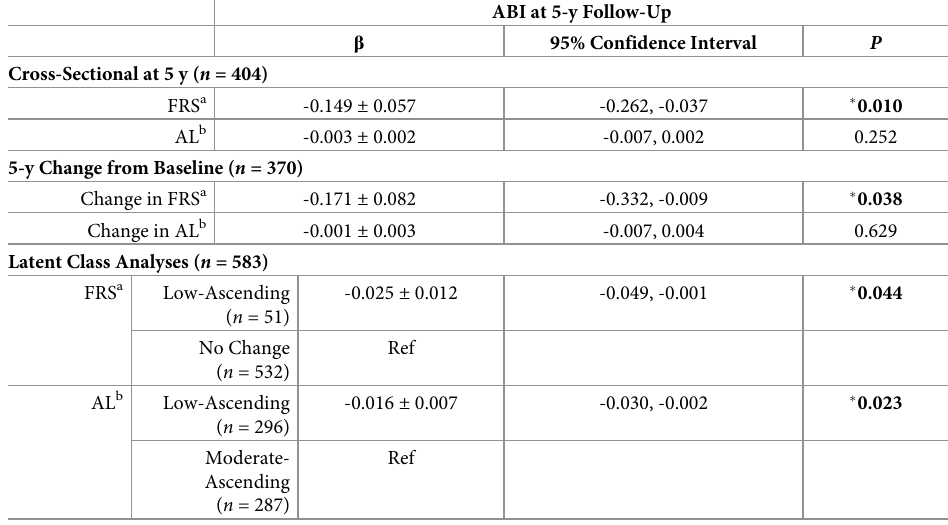
Note: Boldface indicates statistical significance ( � P < 0.05). a Models with FRS were adjusted for educational attainment, physical activity score, and alcohol consumption. b Models with AL were adjusted for sex, age, educational attainment, physical activity score, alcohol consumption, smoking and white blood cell